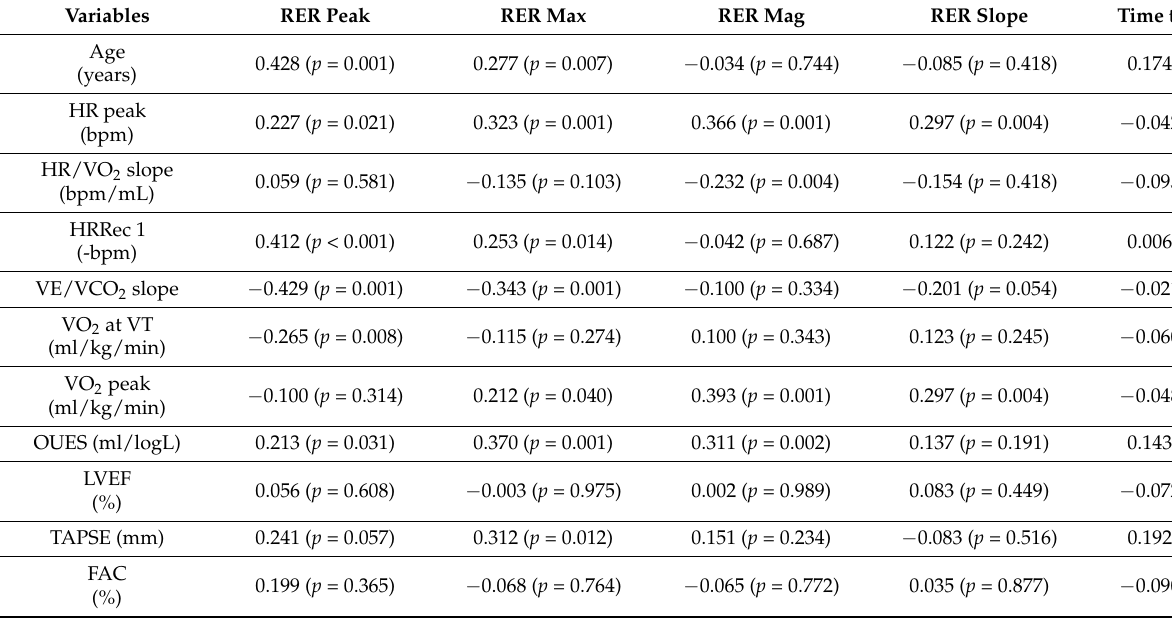
Table 4. Correlations between the respiratory exchange ratio (RER) recovery parameters and car-